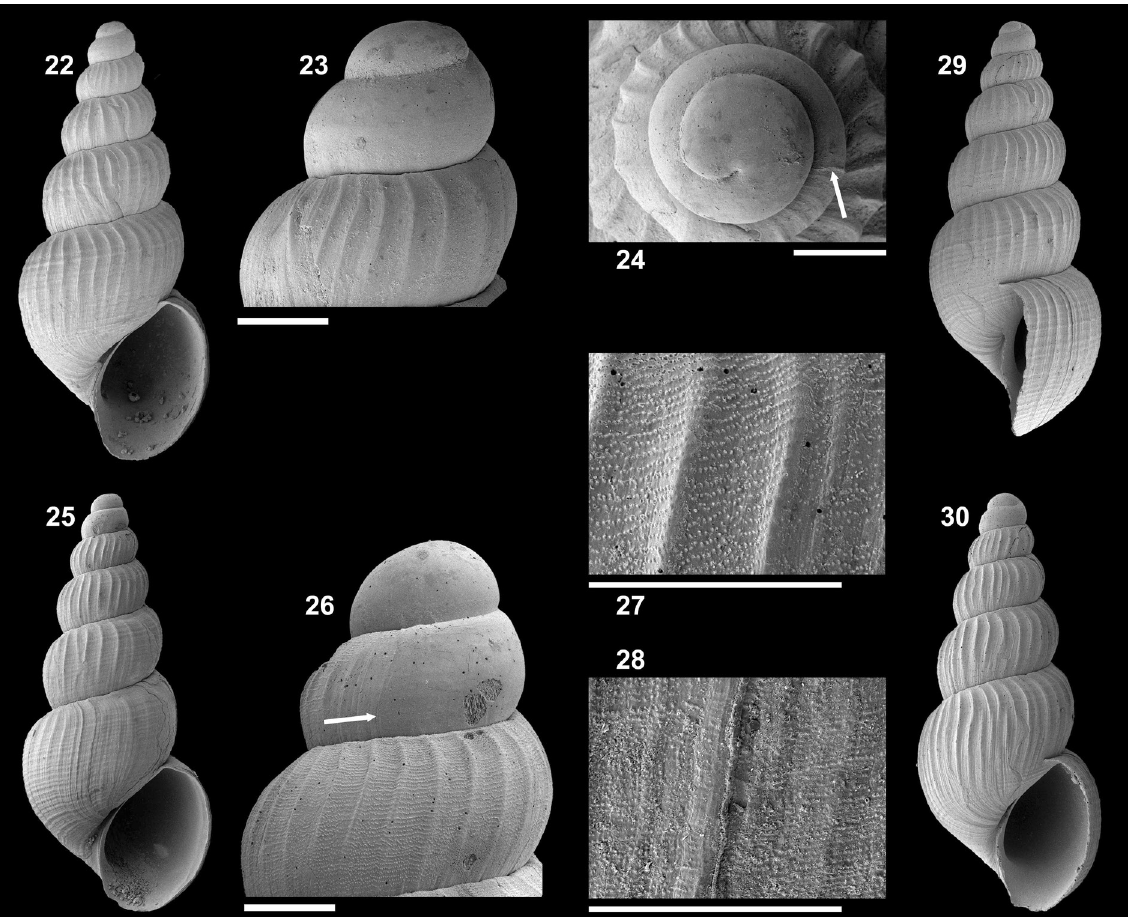
22–24 . Paratype (SMF3658965). 22 . Ventral view, H = 3.8 mm, W = 1.7 mm, Ha = 1.3 mm, apical angle = 30°. 23–24 . Protoconch, Wp = 0.44 mm. 25–28 . Holotype (SMF358964). 25 . Ventral view, H = 4.1 mm, W = 1.8 mm, Ha = 1.4 mm, apical angle = 29°. 26 . Protoconch, Wp = 0.44 mm, arrow at lip. 27 . Sculpture first whorl. 28 . Sculpture body whorl. 29–30 . Paratype (SMF3658965), H = 3.6 mm, W = 1.5 mm, Ha = 1.3 mm, apical angle = 29°, protoconch, Wp = 0.45 mm. Scale bars = 0.2